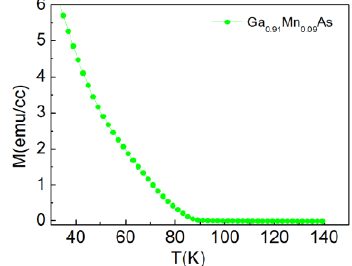
Fig. 2. The magnetization curve of Ga 0.91 Mn 0.09 As. The Curie temperature is about